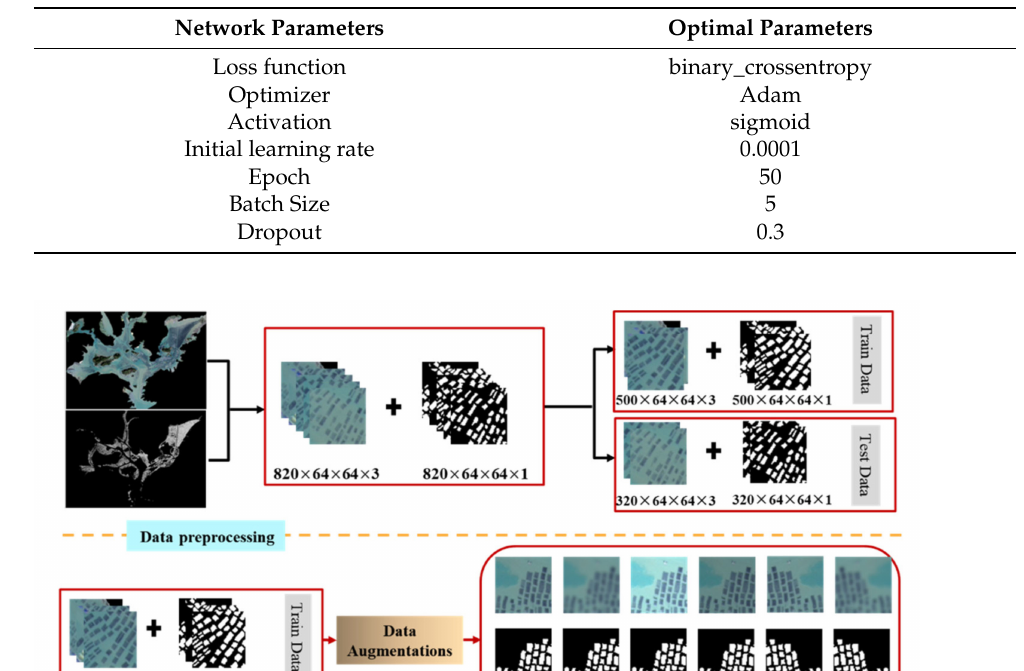
Table 3. Network parameters and the optimal values of RaftNet.